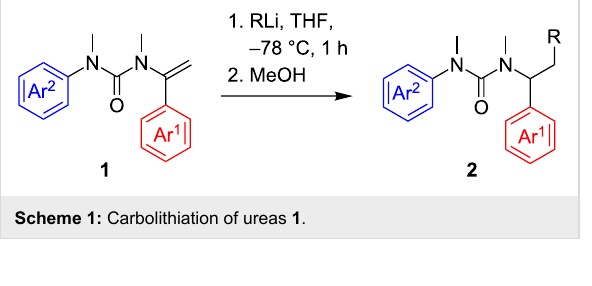
Table 1: Organolithium addition to ureas 1 .